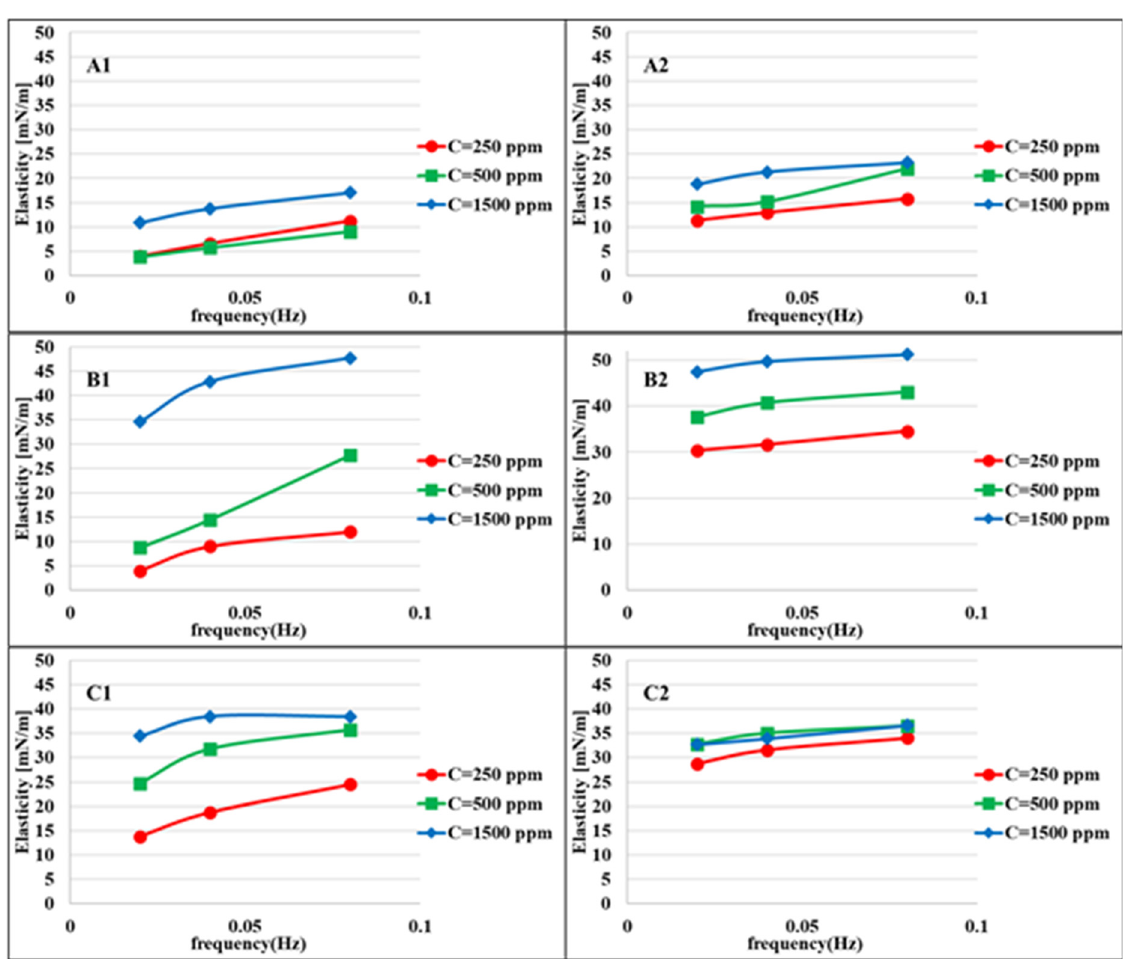
Figure 4. Interfacial dilational elasticity for suspensions of bacteria with different hydrophobicity measured at different adsorption layer ages and different frequencies at the water/heptane interface: ( A1 ) ( MJ02 , H = 2%, first period t = 100–400 s); ( A2 ) (second period t = 900–1200 s); ( B1 ) ( MJ03 , H = 34%, first period); ( B2 ), (second period); ( C1 ), ( RAG1 , H = 79%, first period); ( C2 ) (second period).